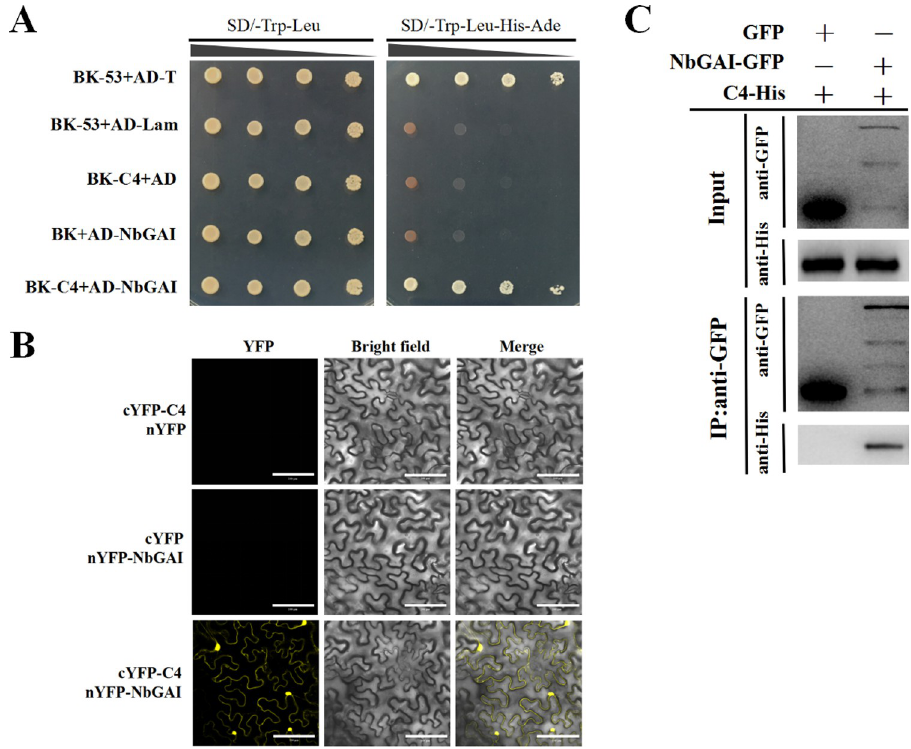
Fig 2. ALCScV C4 interacts with NbGAI in vitro and in vivo . (A) Results of the Y2H assay show the interaction between ALCScV C4 and NbGAI in yeast cells. Recombinant plasmids were co-transformed, in various combinations, into S . cerevisiae strain AH109 cells using the lithium acetate method. The transformants were serially diluted 10-fold and then grown on SD/-Trp/-Leu or SD/-Trp/-Leu/-His/-Ade selective medium. Images were taken at 72 hpi. (B) Results of the BiFC assay show the interaction between ALCScV C4 and NbGAI in vivo . Leaves co-expressing cYFP-C4 and nYFP, cYFP and nYFP-NbGAI, or cYFP-C4 and nYFP-NbGAI were examined and imaged under a confocal microscope equipped with a FITC filter. Scale bar = 100 μ m. (C) Results of the Co-IP assay show the interaction between ALCScV C4 and NbGAI in vivo . C4-His and NbGAI-GFP or C4-His and GFP (control) were co-expressed in N . benthamiana leaves. Total protein was extracted from the infiltrated leaf samples at 2 dpi. The input and the co- immunoprecipitated proteins were analyzed through Western blot analyses using an anti-GFP or an anti-His